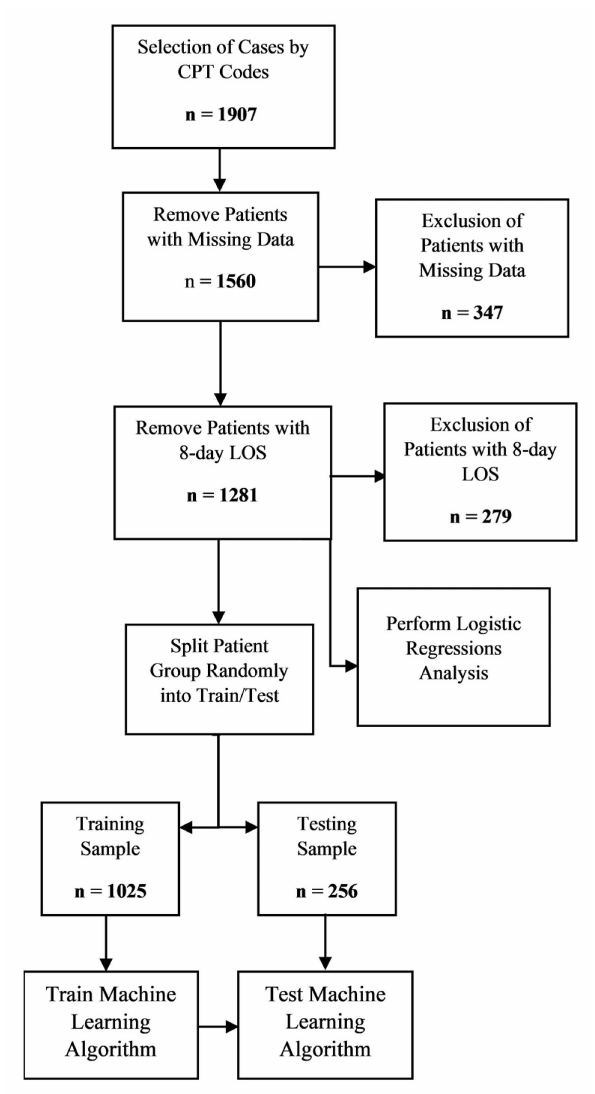
moved from the forest plots due to near-zero confidence interval ranges and odds ratios close to 1.